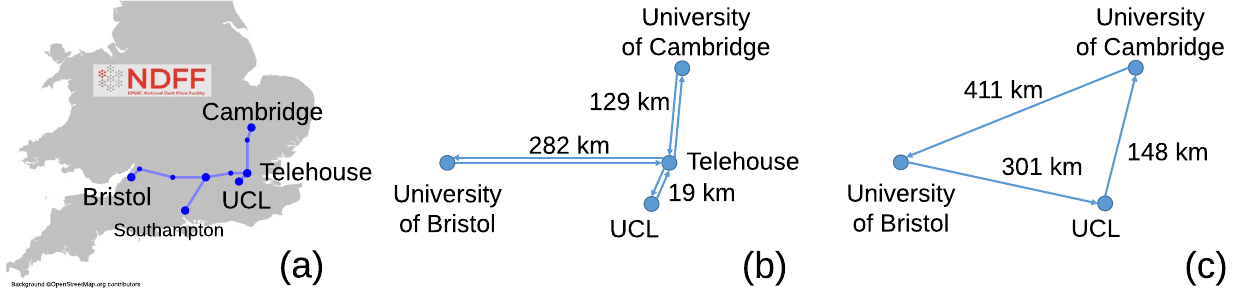
Figure 1. Network topology. The installed NDFF ( a ), the configured physical topology ( b ), and the virtual topology ( c